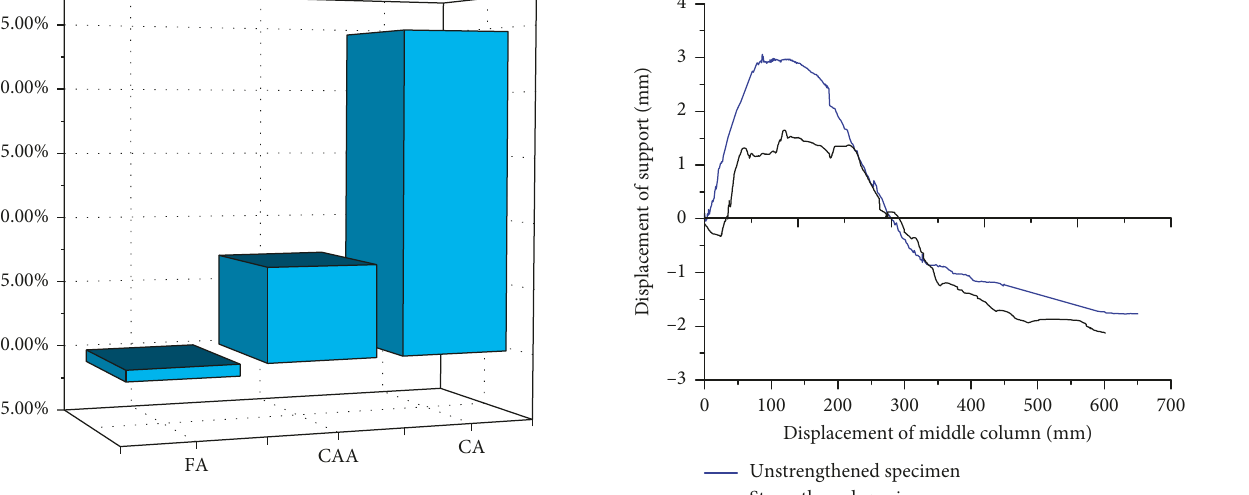
Figure 10: Increase coefficient of load capacity in different stages.